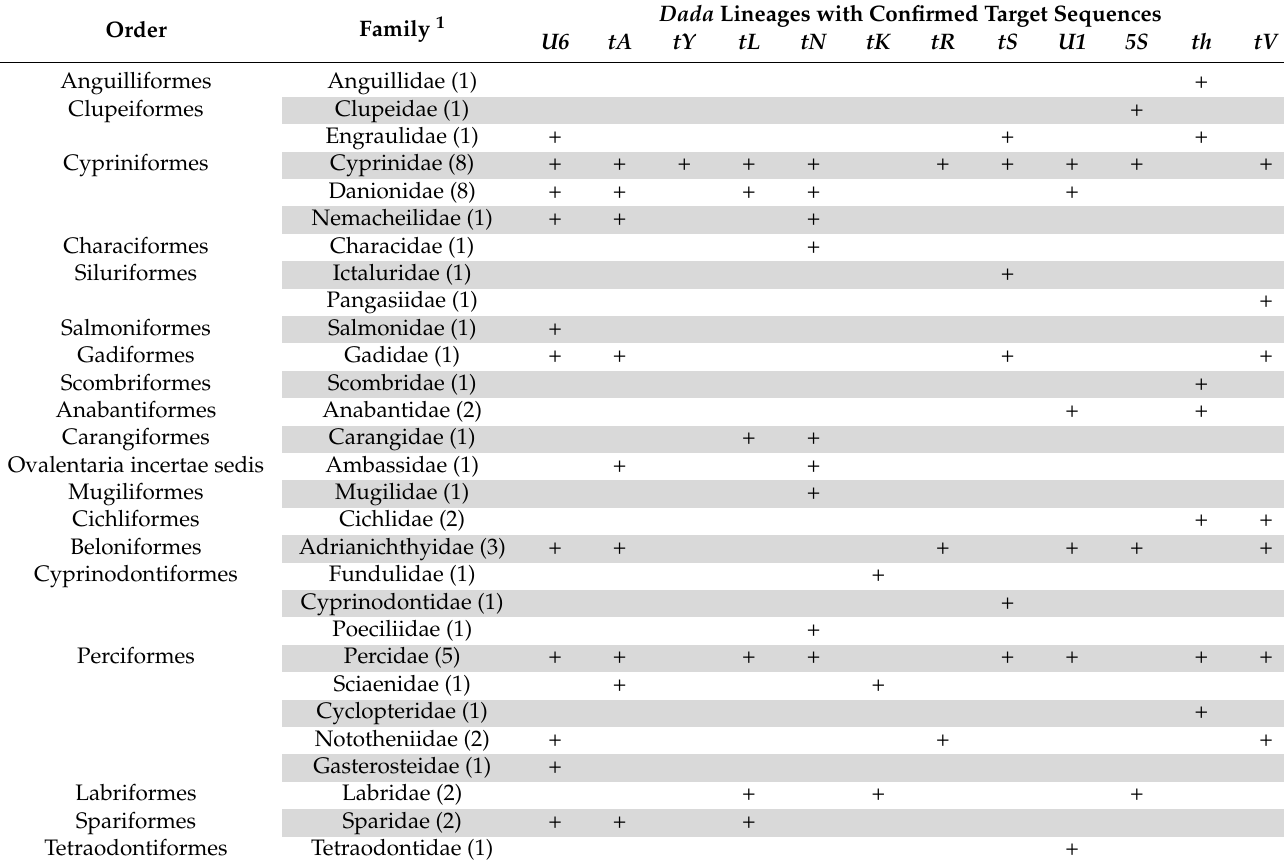
Table 1. Distribution of Dada families in